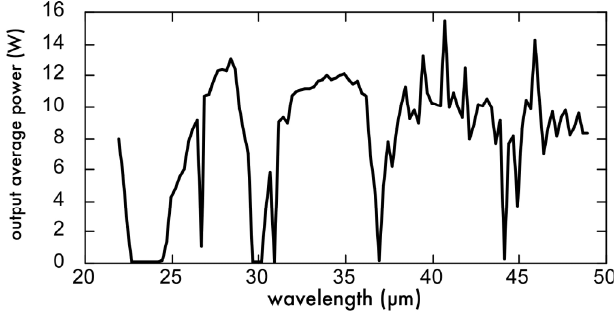
FIG. 12. Simulation of output power on the U100 FEL in ELBE, at 32 MeV, with 2 mm hole